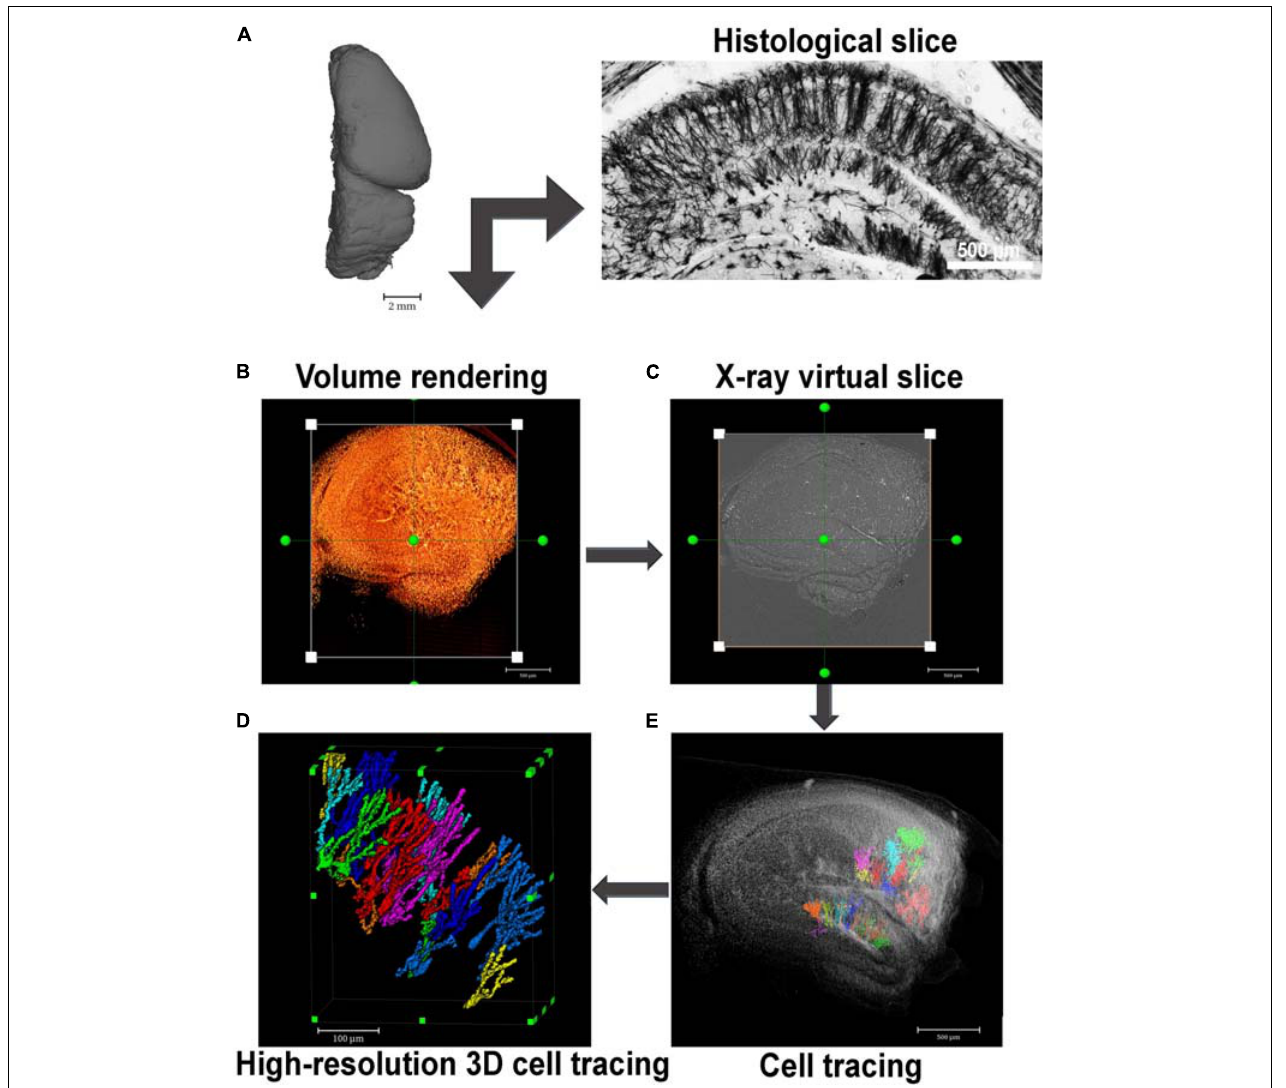
FIGURE 4 | Virtual histology in 3D with x-ray absorption microtomography. (A) A paraffin-embedded mouse hemisphere after Golgi-Cox staining and embedded in paraffin can be seen by histology or x-ray microtomography. Far right image shows a histological section of a Golgi-Cox-impregnated mouse hippocampus exhibiting the neurons of the sliced structure evenly and reliably stained. (B) This image shows a 3D image rendering of a Golgi-Cox-impregnated mouse hippocampus. (C) Virtually reconstructed image of one slice of the rendered image represented in panel (B) . (D) Volume rendering of some selected slices of the tissue shown in panel (A) where some neurons were segmented. (E) High-resolution image of segmented neurons located at the dentate gyrus of the mouse hippocampus imaged in panel (B)